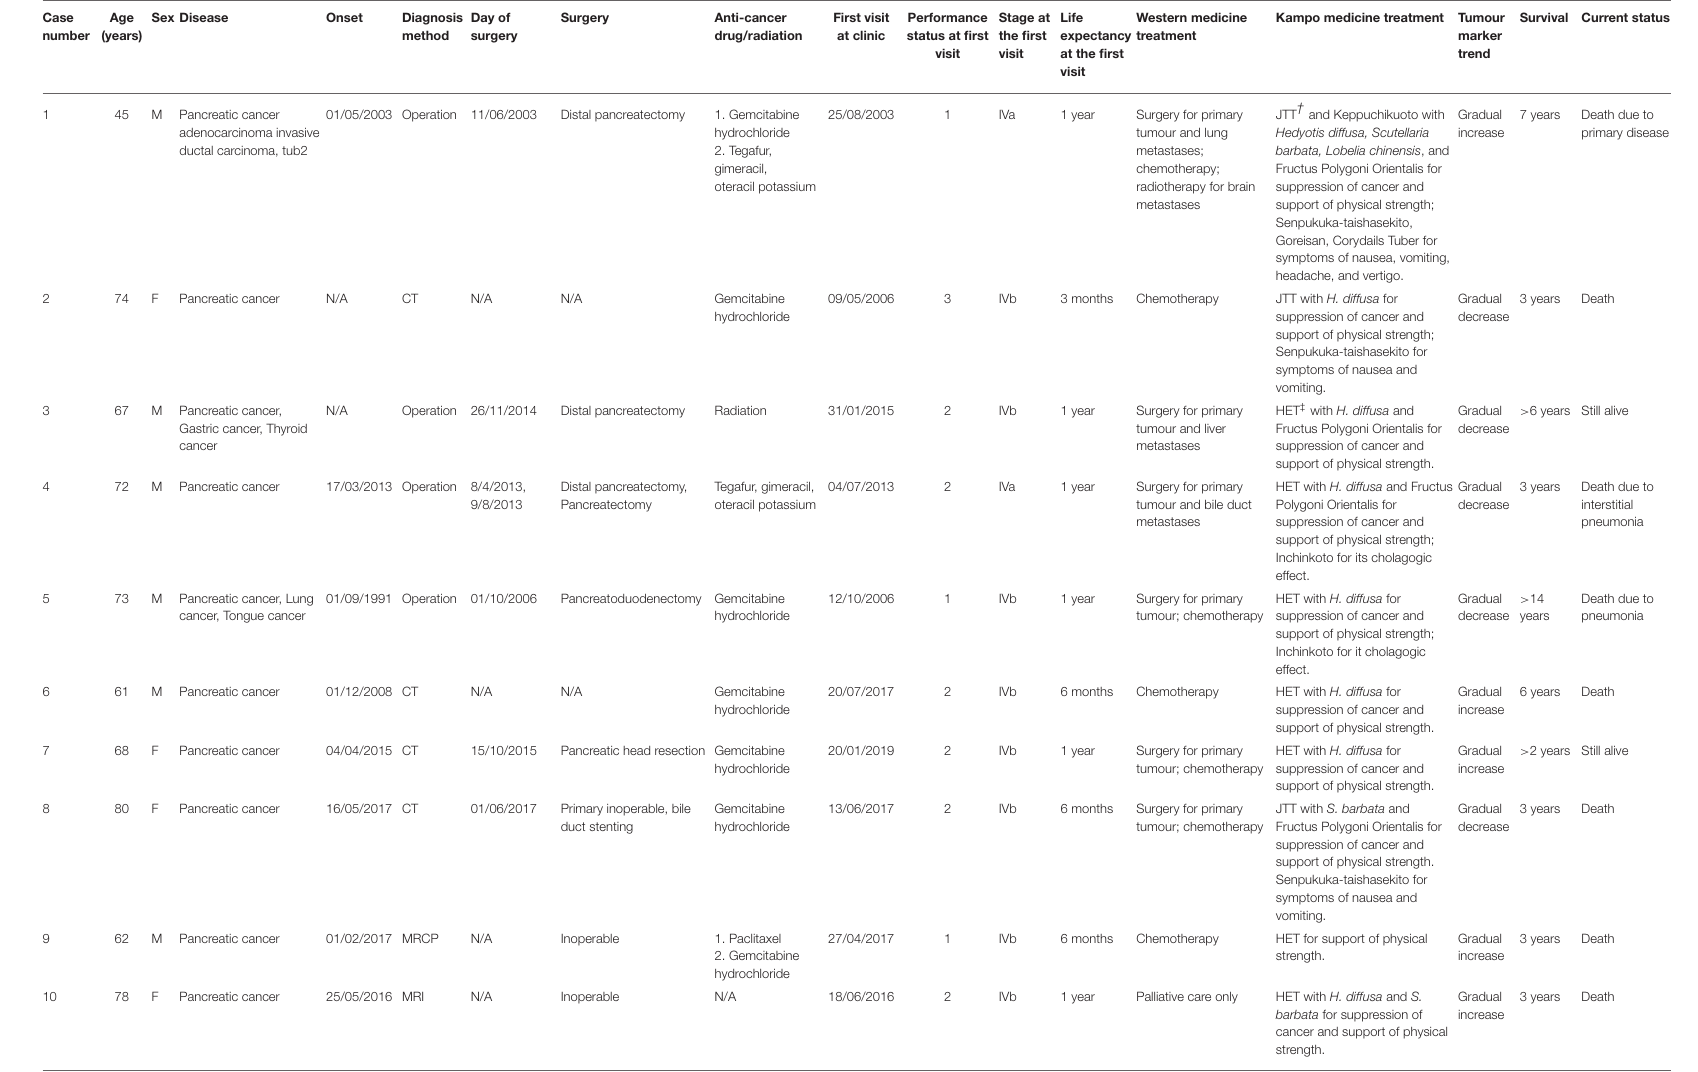
TABLE 2 | Patients with advanced pancreatic cancer who were treated with Kampo medicine and lived at least twice as long as the prognosis determined at the time of initial